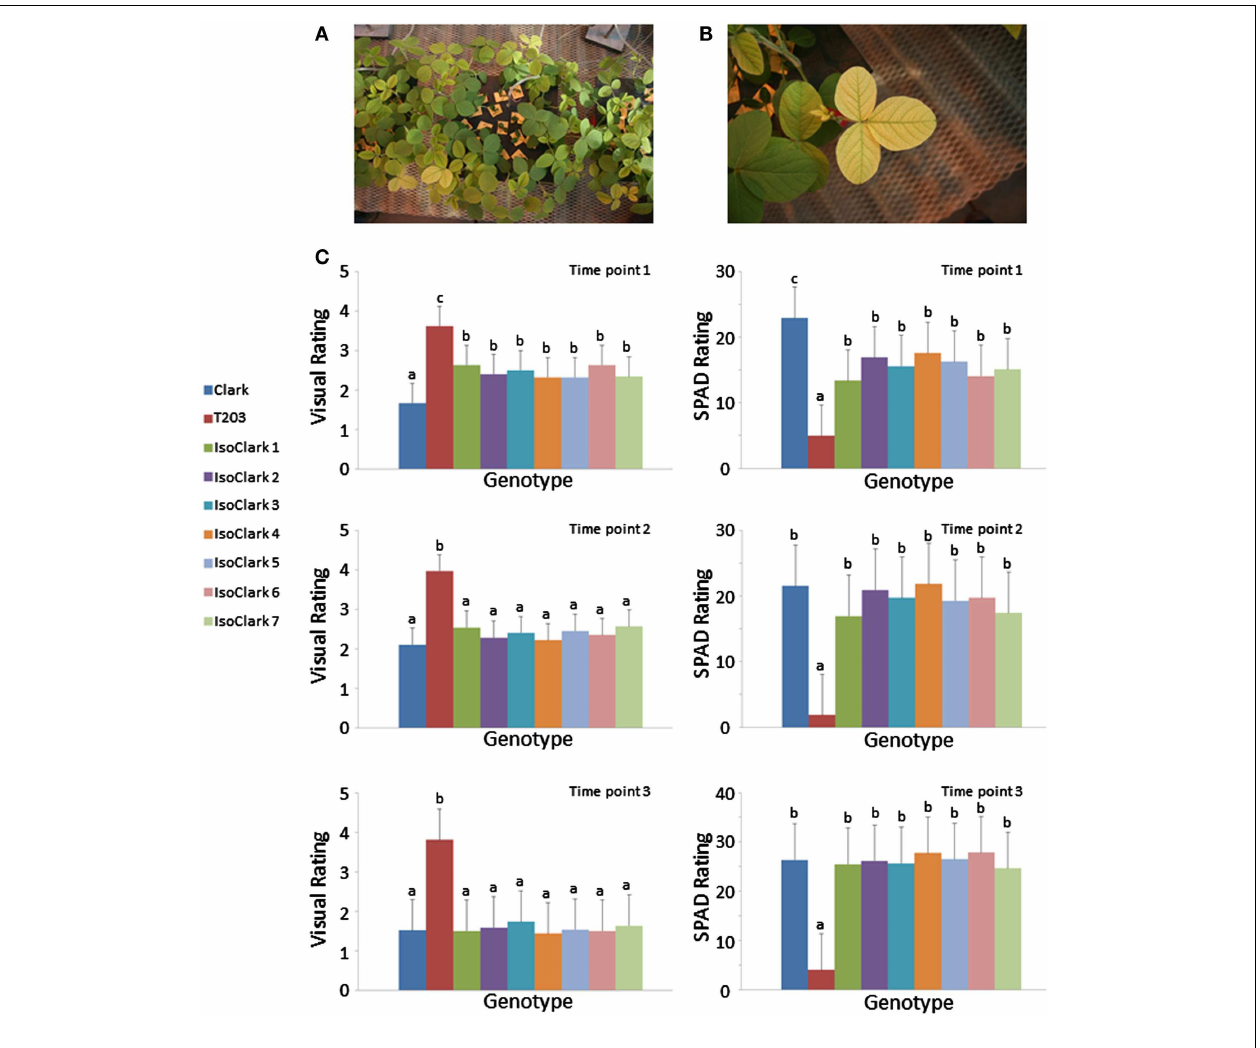
trifoliate. (C) Mean separation (LSD) for phenotypes as scored by visual ratings and SPAD measurements over three time points. Letters a, b, c, indicate when treatment means are in significantly different